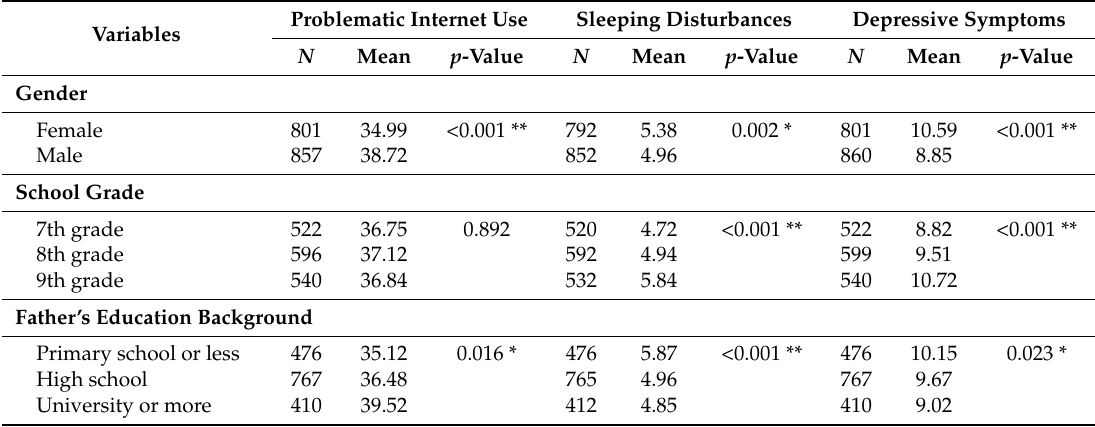
Table 3. Univariable associations of problematic Internet use, sleeping disturbances and depressive symptoms with socio-demographic factors and negative effects of Internet